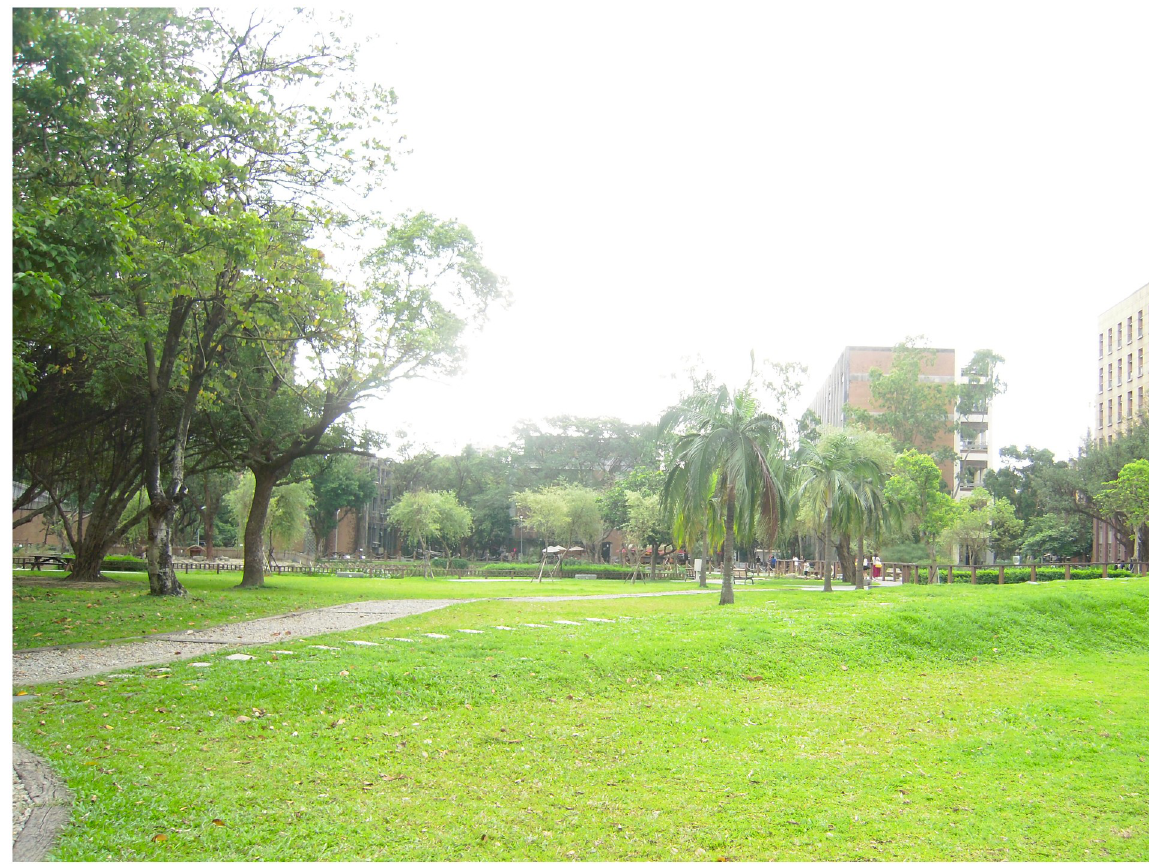
Fig 3. The natural environment, beside an ecological pond, where primary students usually practice